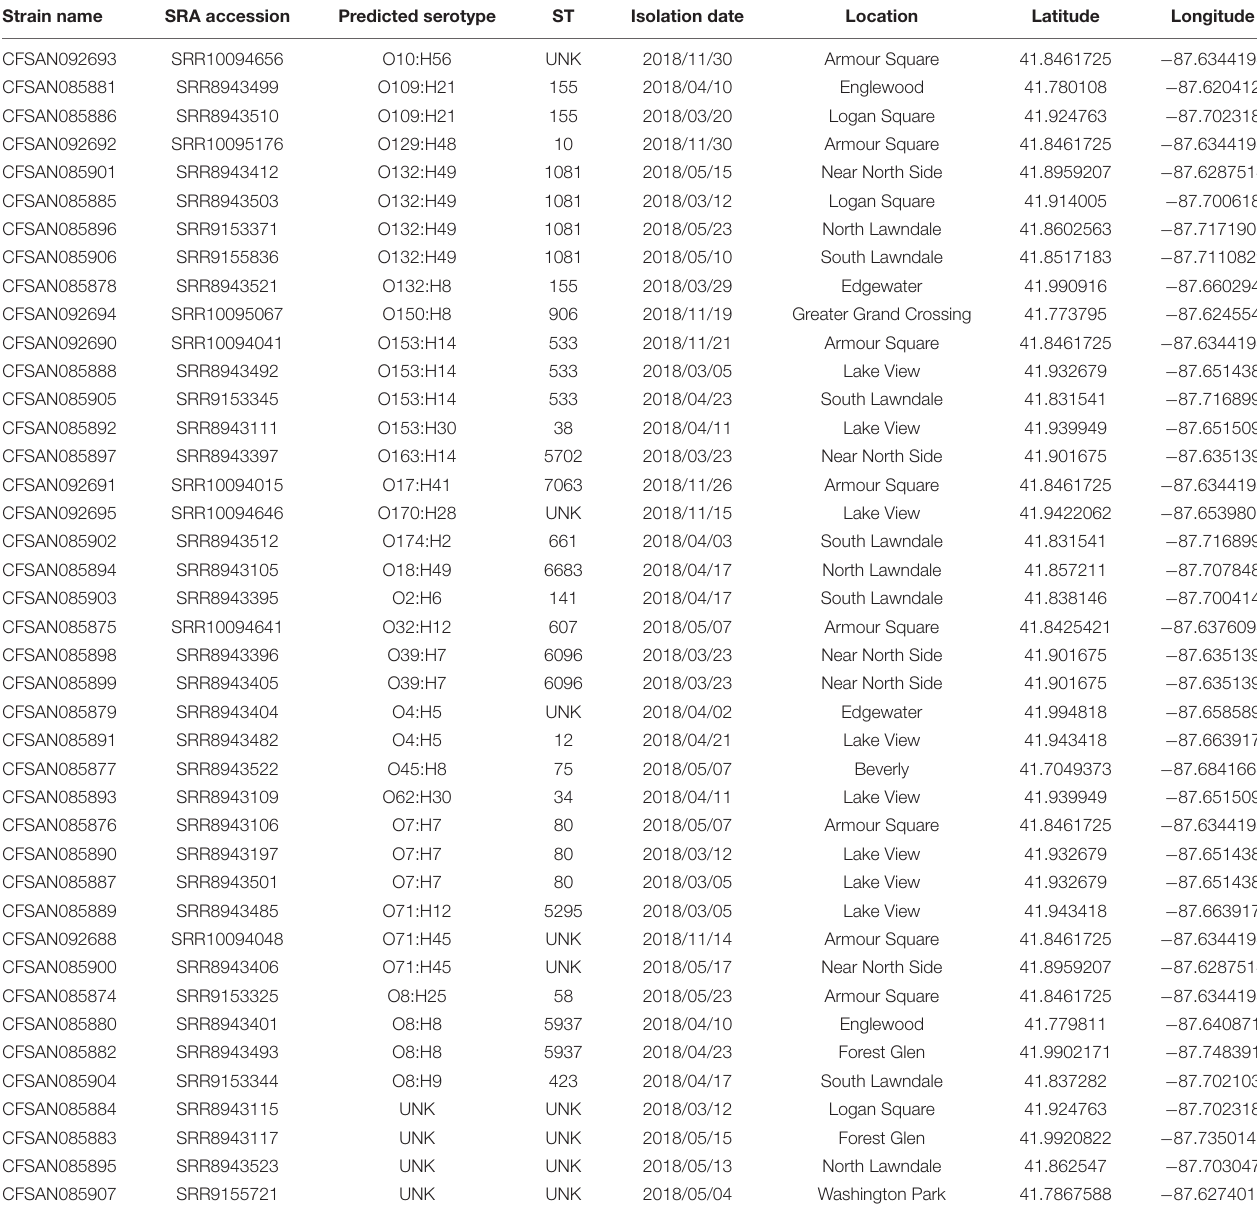
TABLE 1 | Sample information for the 41 E. coli